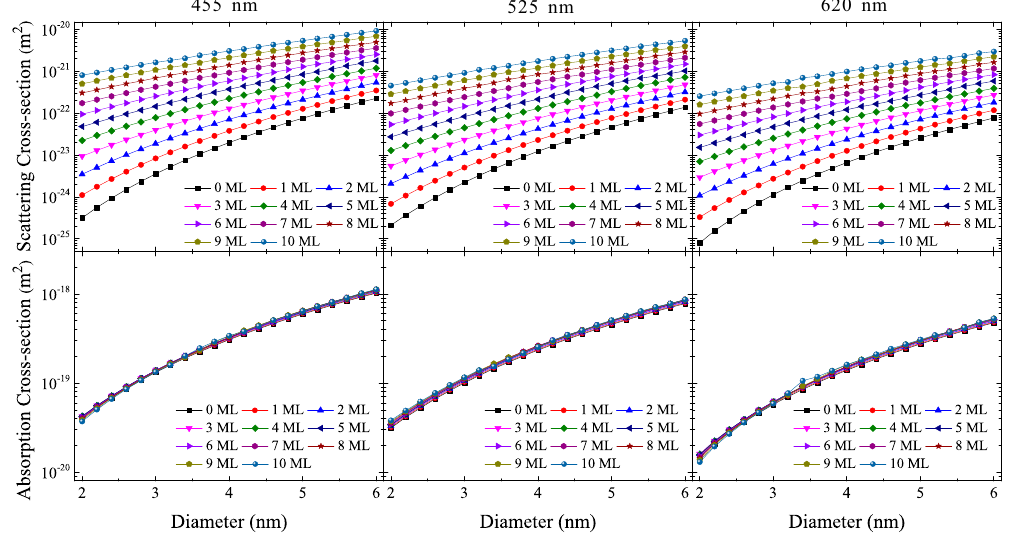
Figure 2. Scattering and absorption cross-sections of CdSe/ZnS quantum dots (QDs). (MLs: molecule layers).